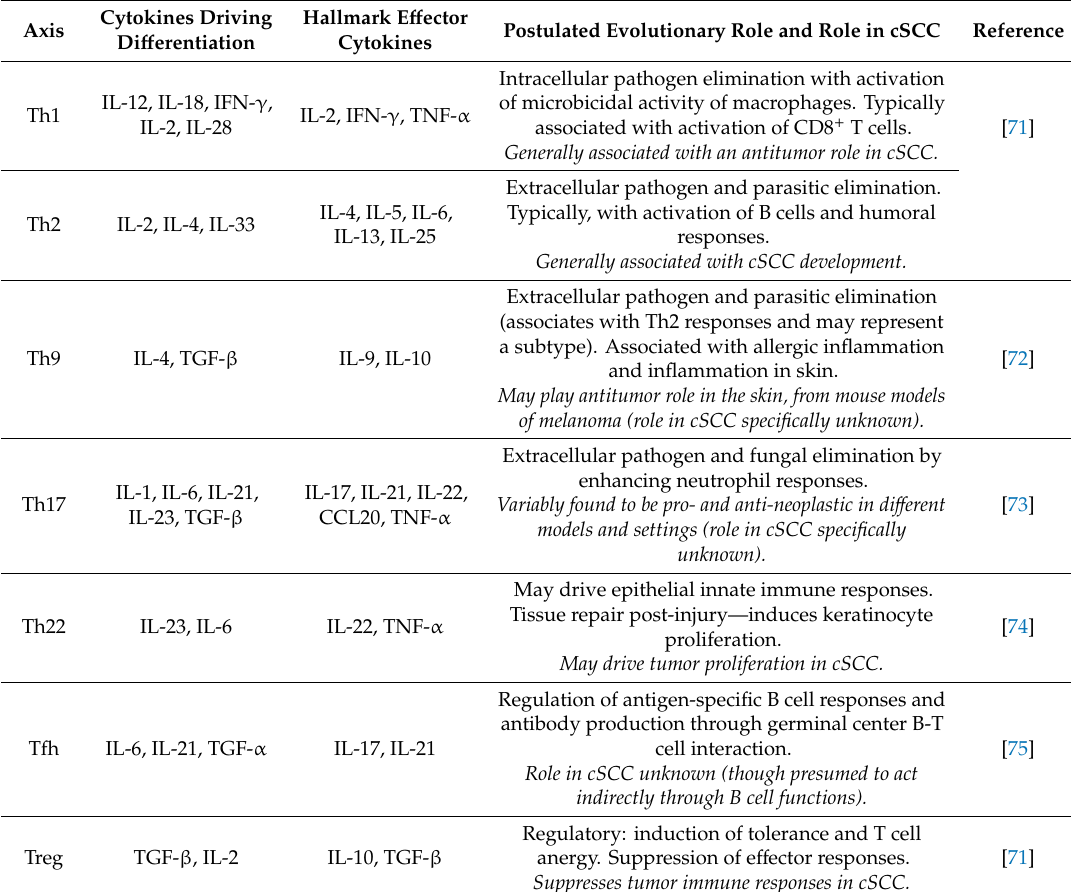
Table 1. Summary of described T cell polarization axes and their role in cutaneous squamous cell carcinoma (cSCC). In italics is a summary of the role of each axis in cSCC development. IL, interleukin; IFN, interferon; TGF, transforming growth factor; TNF, tumor necrosis factor; and CCL, chemokine